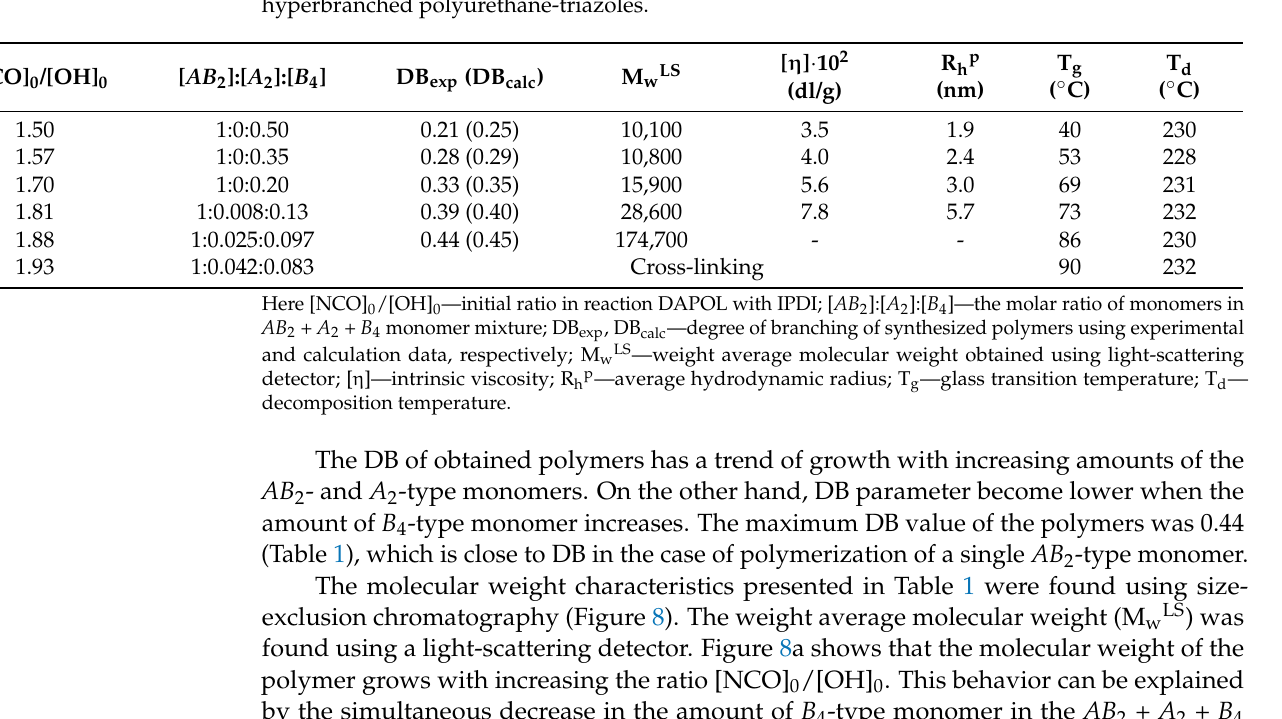
Table 1. Structural parameters, molecular weights, hydrodynamic and thermal characteristics of hyperbranched polyurethane-triazoles.